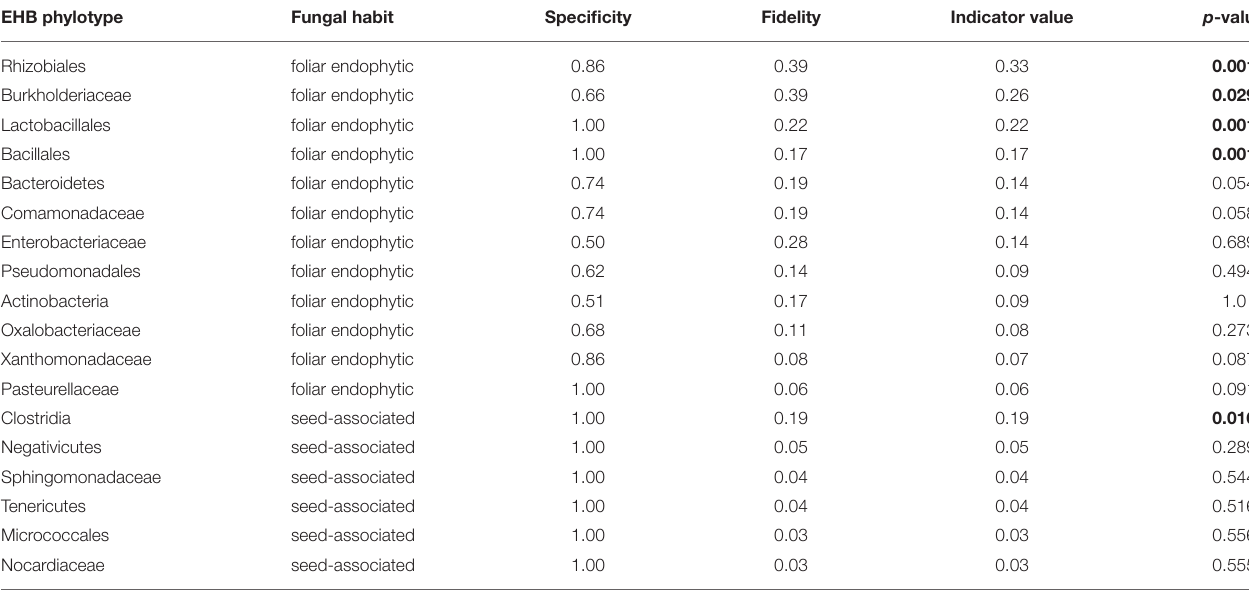
TABLE 1 | Indicator species analysis identifies the EHB OTUs that are significantly associated with a given fungal habit (seed-associated or foliar